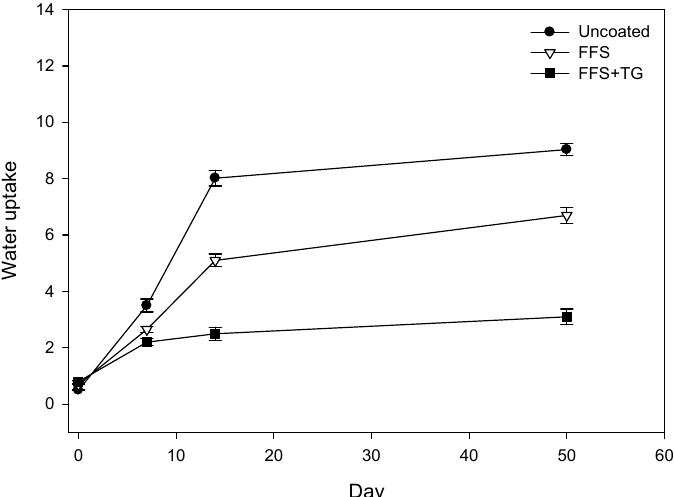
Figure 4. Water content (%) of uncoated and coated peanuts with FFS or FFS+TG during 50 days of storage. N = 24, values shown are mean ± standard deviation.